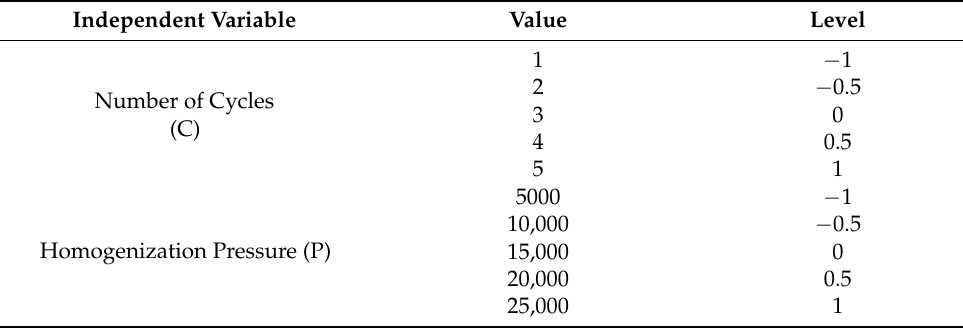
Table 1. Processing variable conditions used for the present